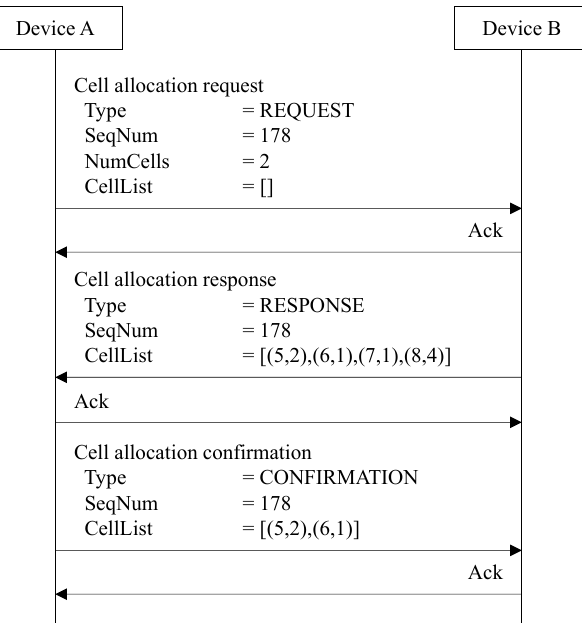
Figure 3. Example of three-step 6P transaction.